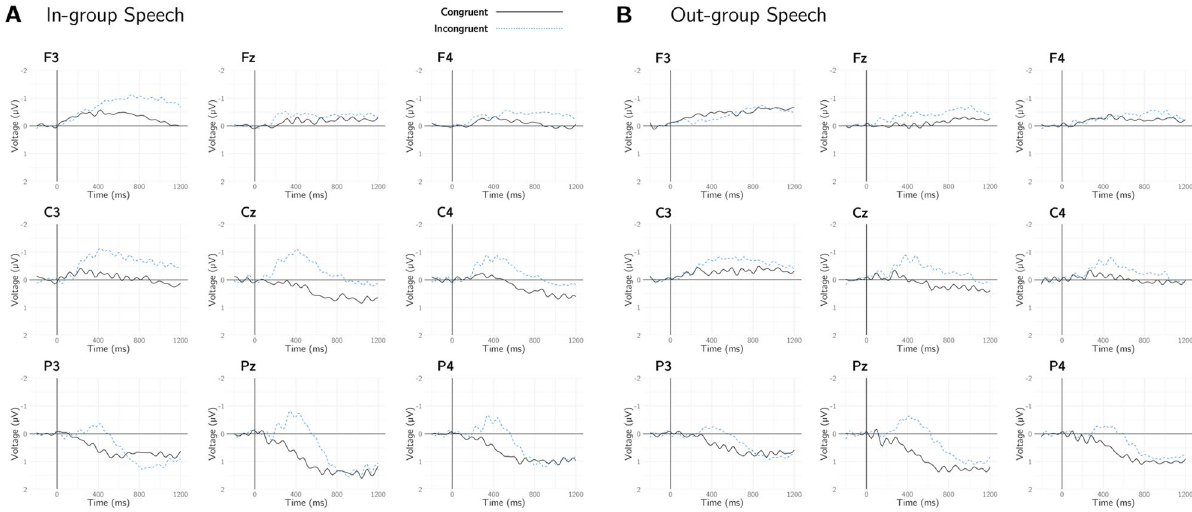
Figure 1. Average responses to semantic congruence and incongruence in in-group and out-group speech for three frontal, three central, and three posterior electrode